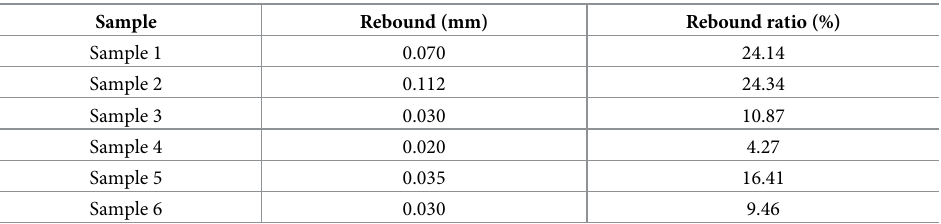
Table 7. Rebound and corresponding ratio for each soil